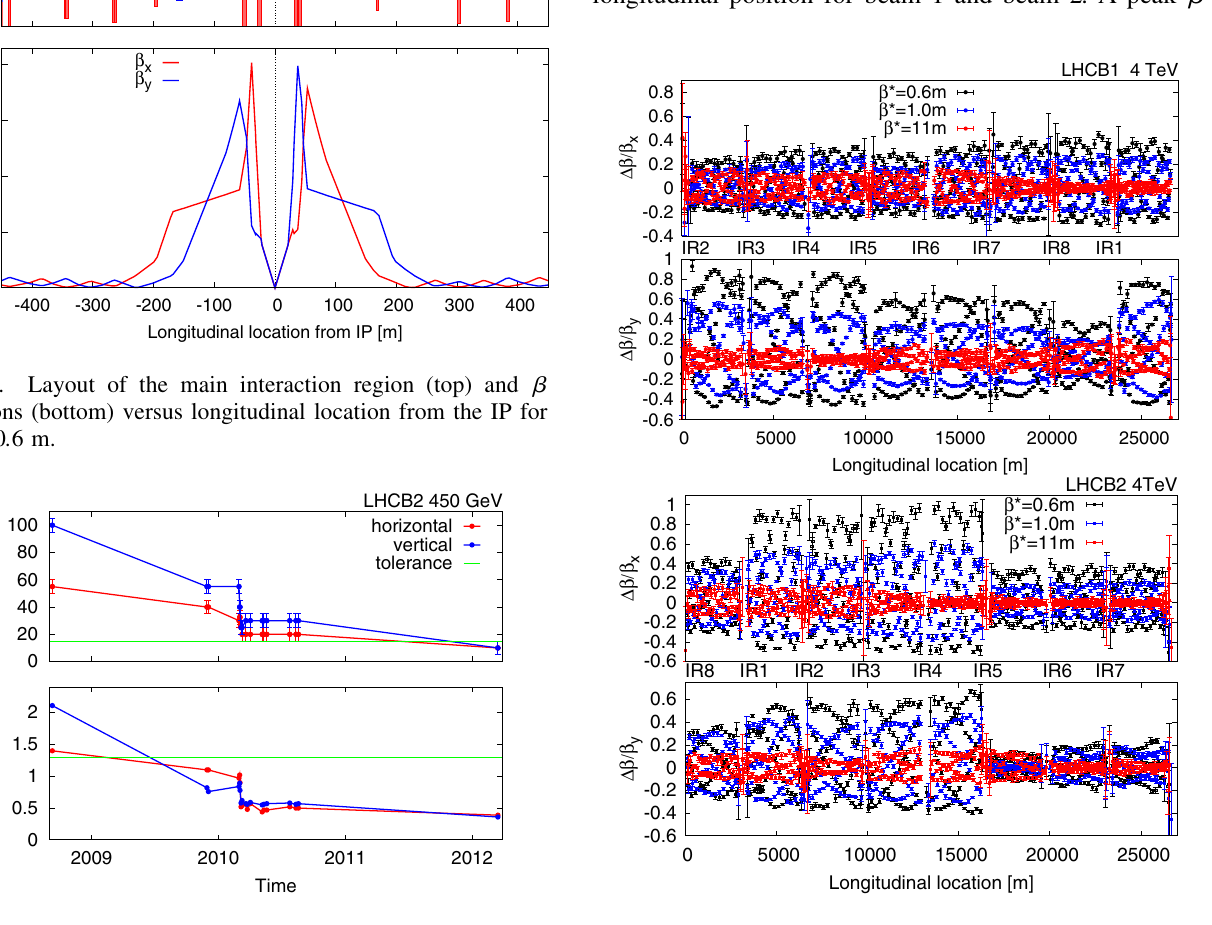
FIG. 3. Beam 1 (top) and beam 2 (bottom) (cid:1) beating at three IP1 and IP5 (cid:1) (cid:1) values during the squeeze of the virgin